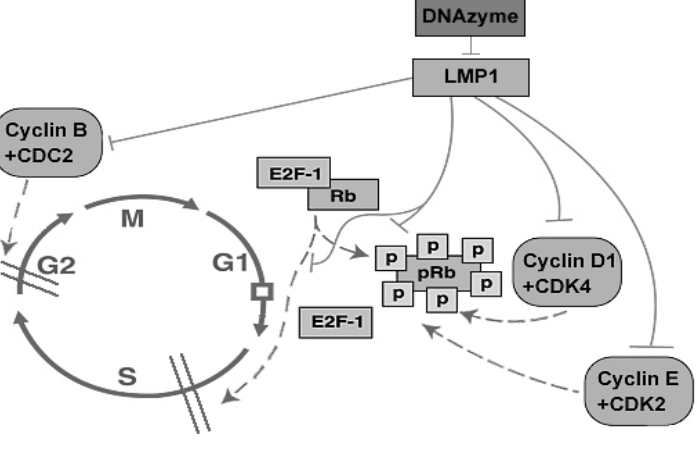
Figure 3. Possible mechanisms for the S phase arrest caused by down-regulation of the LMP1 expression by DZ1 through G1/S and G2/M checkpoint